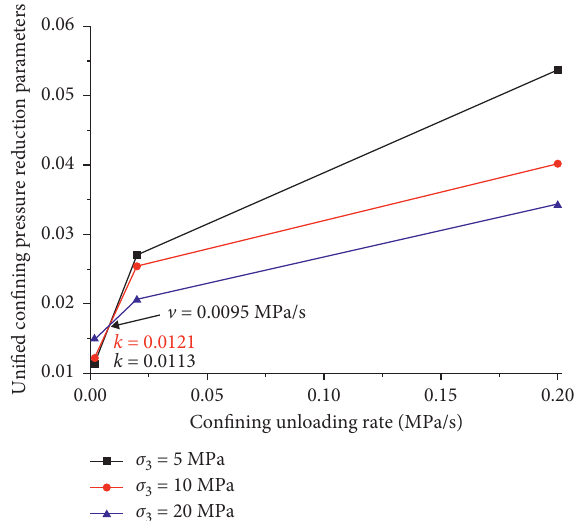
Figure 9: Mohr–Coulomb strength curves of granite. Table 2: Linear fitting results of two strength criteria.